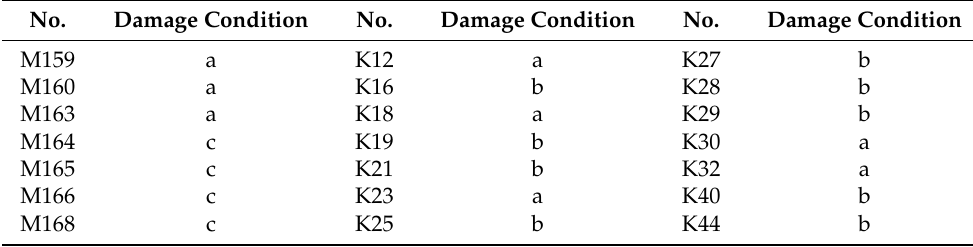
Figure 1. Location of the 88 target bridges over the color composite of the pre-processed pre- and post-event SAR intensity images: ( a ) Seven collapsed and 34 surviving bridges affected by the 2011 Tohoku earthquake on the TerraSAR-X intensity pair, and ( b ) 14 collapsed and 30 surviving bridges affected by the 2020 July floods on the ALOS-2 intensity pair. Table 1. List of the collapsed bridges in the two target events under three damage conditions: (a) Part of the deck was washed away; (b) the deck was completely washed away, with piers left; and (c) the deck was completely washed away, without piers left